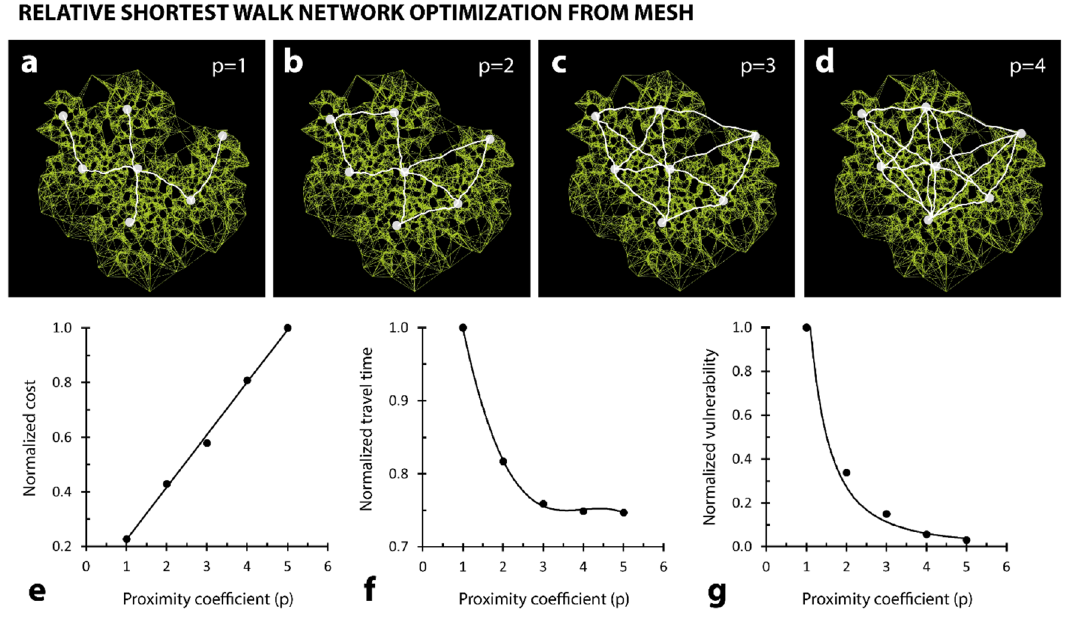
Figure 4. Tunable modelled network behaviour. ( a – d ) Different shortest-walk calculations for the same mesh, but with unique proximity coefficient values. ( e ) Plot relating network cost, normalized to the largest cost, to proximity coefficient. Trendline is a linear function. ( f ) Plot relating network travel time, normalized to the largest travel time, to proximity coefficient. Trendline is a third-order polynomial function. ( g ) Plot relating network vulnerability, normalized to the largest travel vulnerability, to proximity coefficient. Trendline is a power